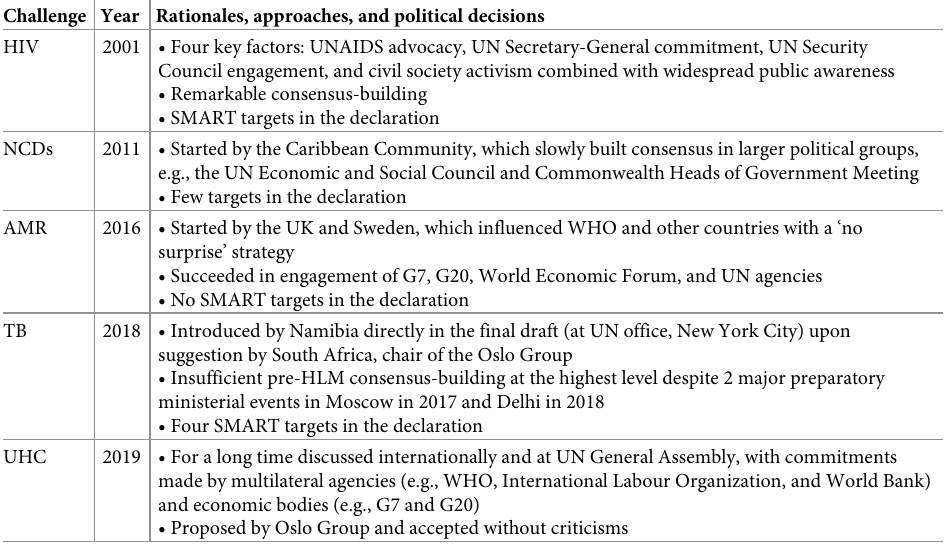
The table shows an overview of the preparatory approaches, political motivations, and main political outcomes for the UN General Assembly special session and HLMs for each health topic.